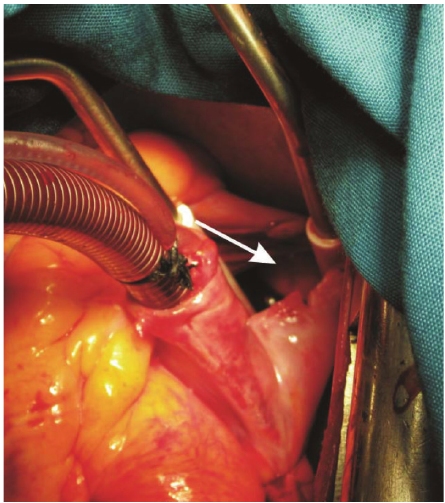
Figure 3: Opened right atrium showing the intra-atrial part of the thrombus